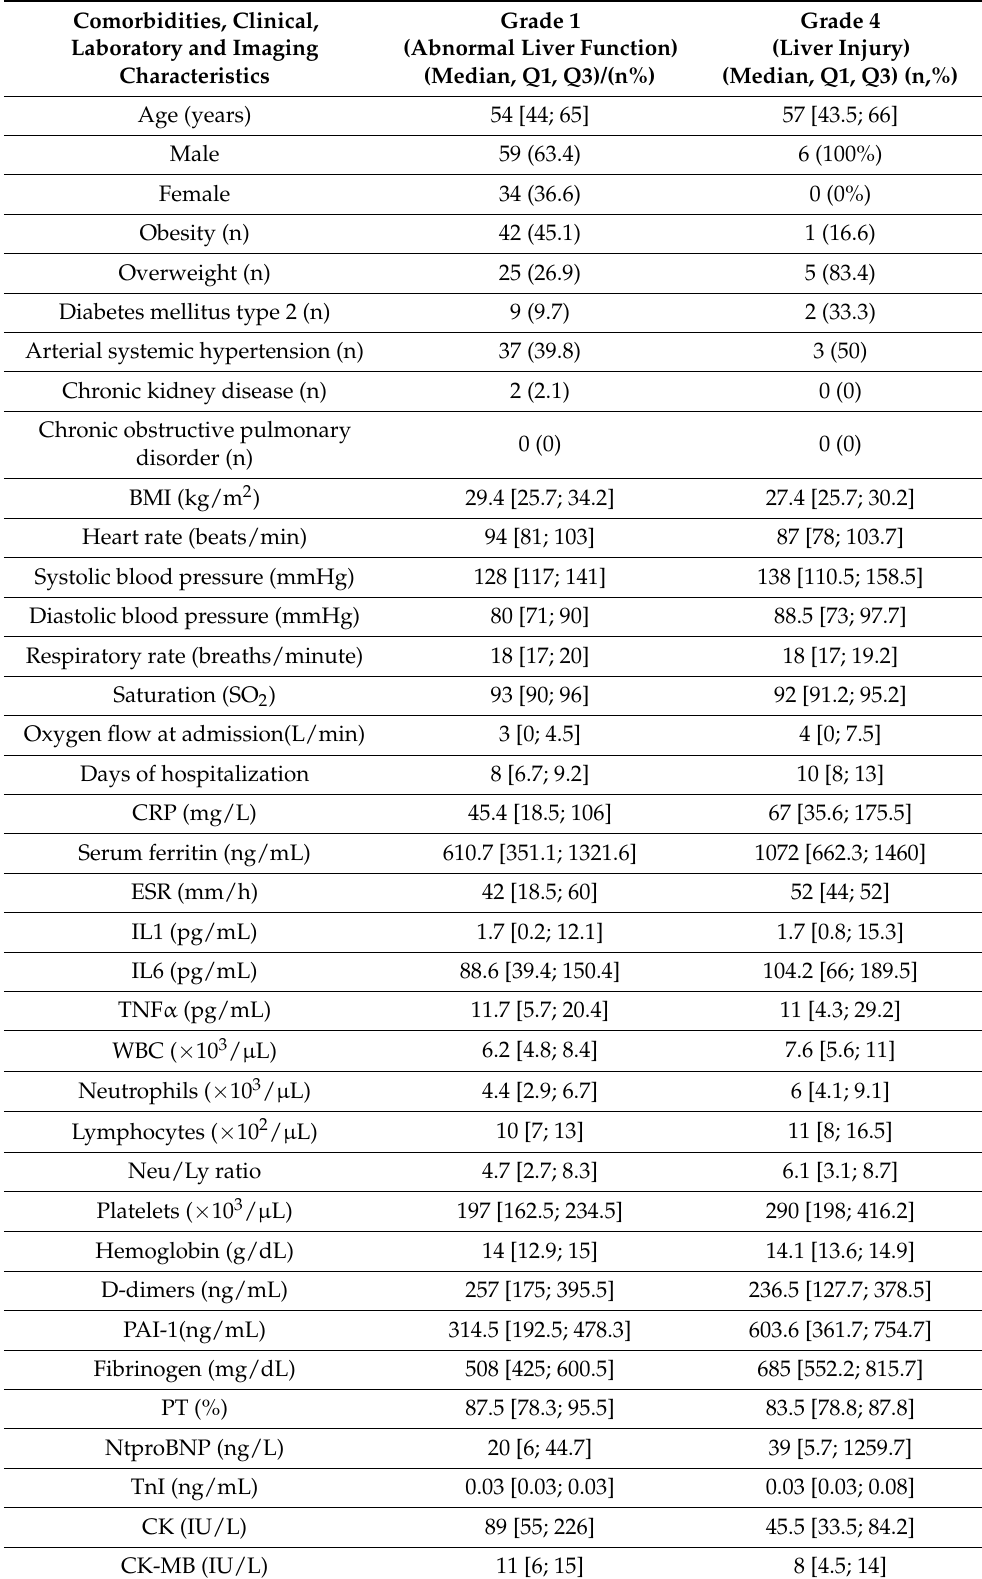
Table 6. Characteristics of abnormal liver function/injuryin COVID-19 patients (grade 1—patients with abnormal liver function and grade 4—patients with liver